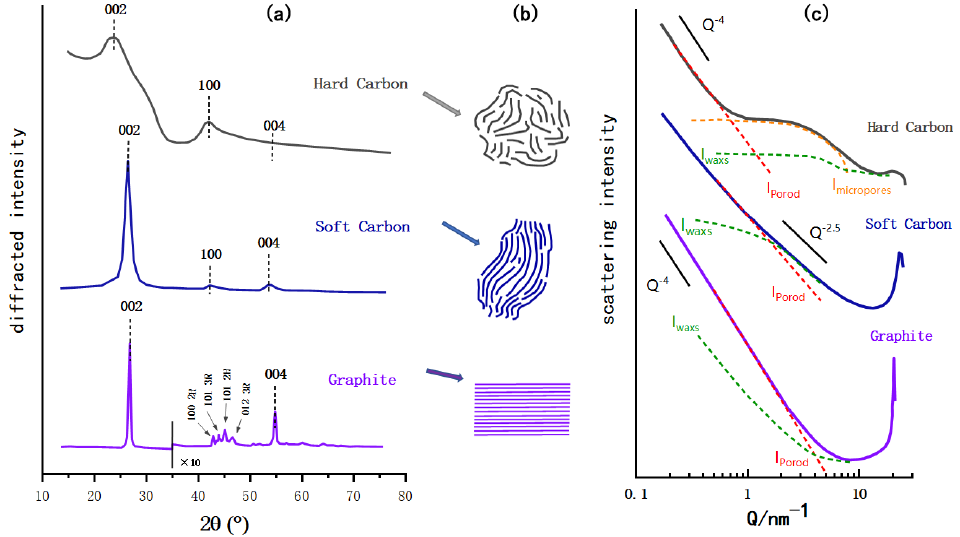
Figure 3. Schematic diagram of HC, soft carbon, and graphite. (a) XRD contrast diagram (modified according to the reference [56], the sharpness of the image after graphite 2θ = 35° as amplified ten times). ( b ) Schematic diagram of the microstructure of three carbon materials. ( c ) SAXs contrast diagram (modified according to the reference [57]; the I waxs , I porod and I micropores are the parameters of the structure and model established in reference).